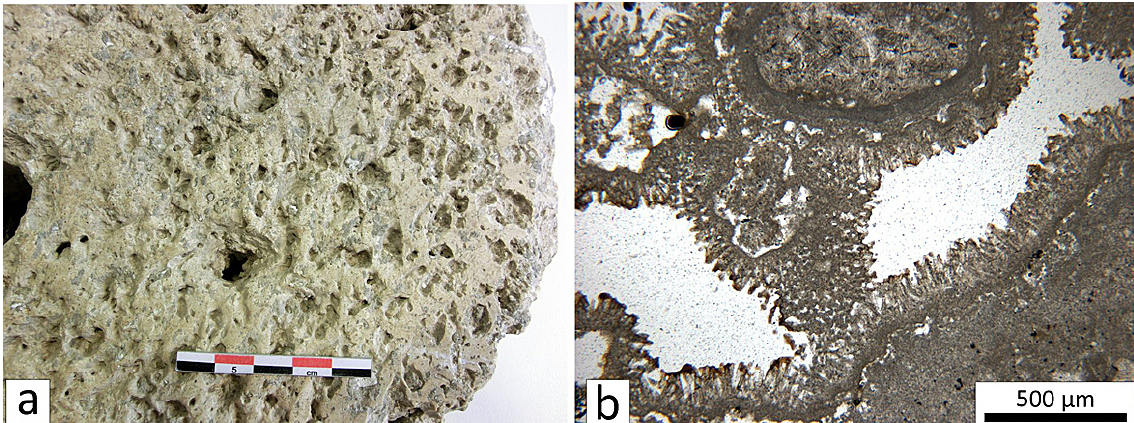
Figure 6. Lacustrine calcareous tufa rotary querns. These are the earliest rotary querns in the Nord-Pas-de-Calais in France. 6a: macrophotography, 6b: microphotography under planed polarised light.